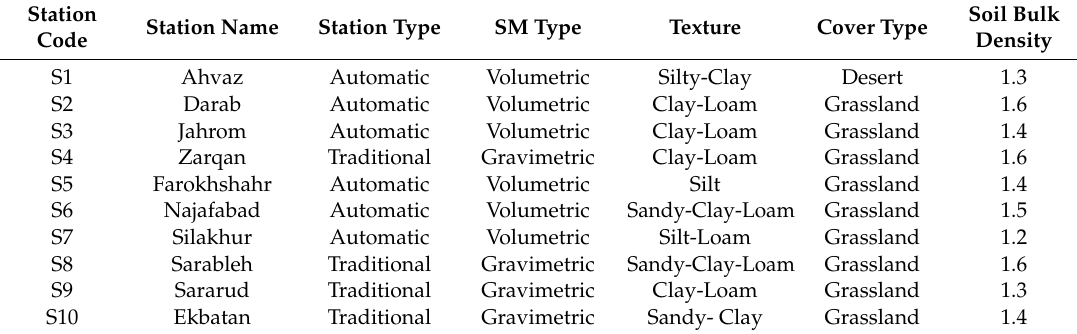
Table 2. Characteristics and land cover of agrometeorological